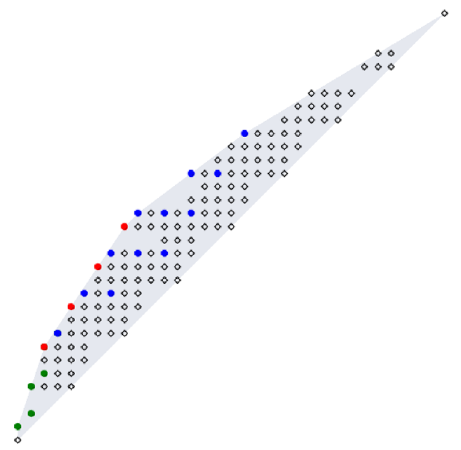
Figure 24 . Newton polygon and the initial form init r 0 (red nodes) for diag(2 ; 4 ; 4)